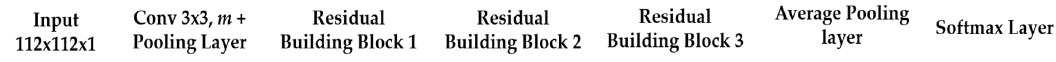
Figure 11. Structure of a single network used during the experiments.